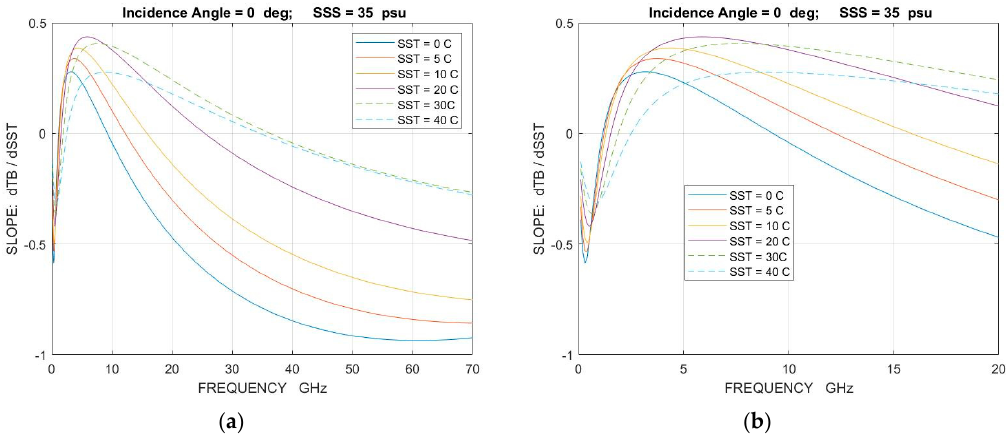
Figure 7. Sensitivity of brightness temperature to changes in temperature, SST, as a function of frequency for selected temperature, at nadir. These curves are for SSS = 35 psu, a flat surface, and use the Klein-Swift [19] model function. The figure on the right (7b) is the same as on the left (7a) but with expanded frequency scale to show detail below 20 GHz.